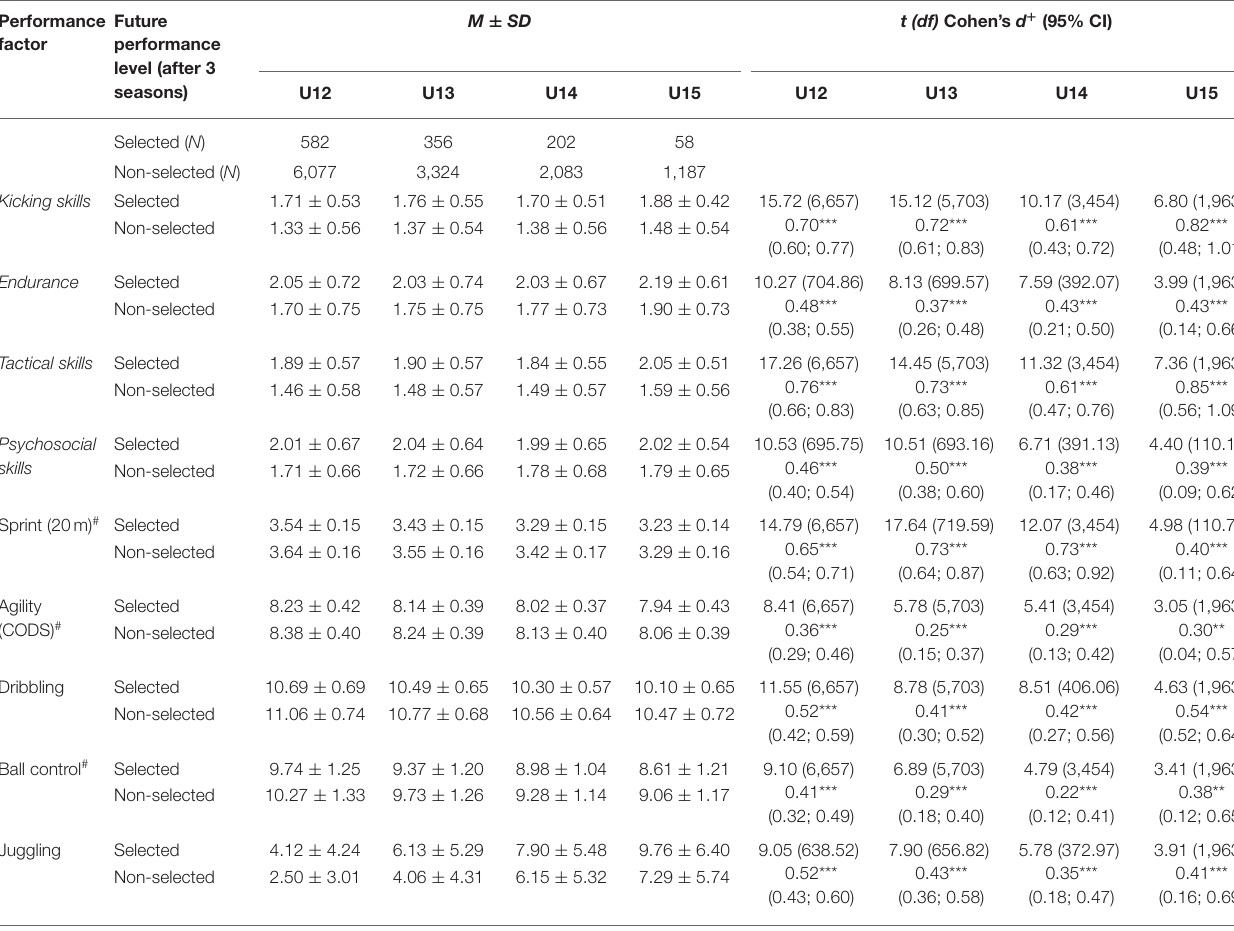
TABLE 3 | Test results for subjectively (printed in italics) and objectively evaluated performance factors of selected and non-selected players separated by age class (U12–U15, N = 13,869). Performance factor